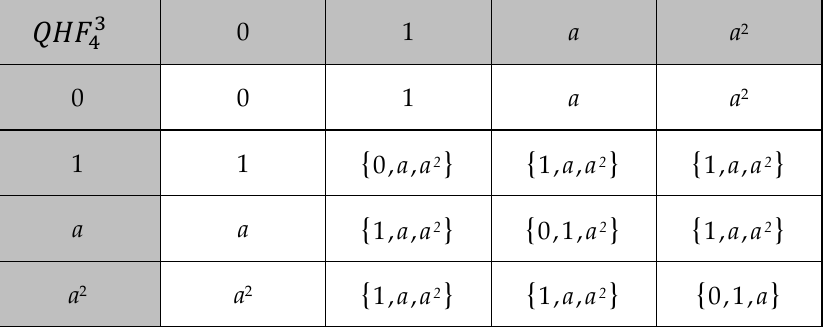
Table 8. The Cayley table of the additive canonical hypergroup of the quotient hyperfield ℤ 13 /{ 1,5,8,12 }.